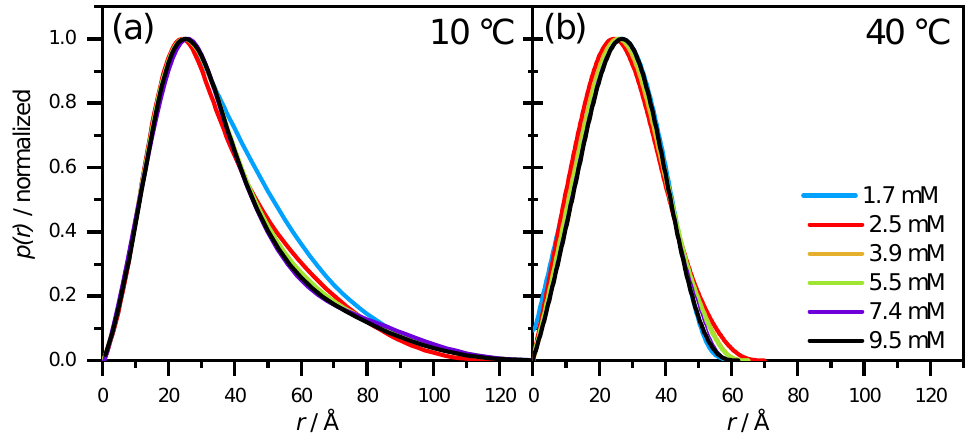
Figure 5. Fits by indirect Fourier transformation (IFT) analysis to small-angle X-ray scattering (SAXS) data of aescin solutions with different concentrations at temperatures of ( a ) 10 and ( b ) 40 °C [57]. The data are scaled by the factors given in gray.